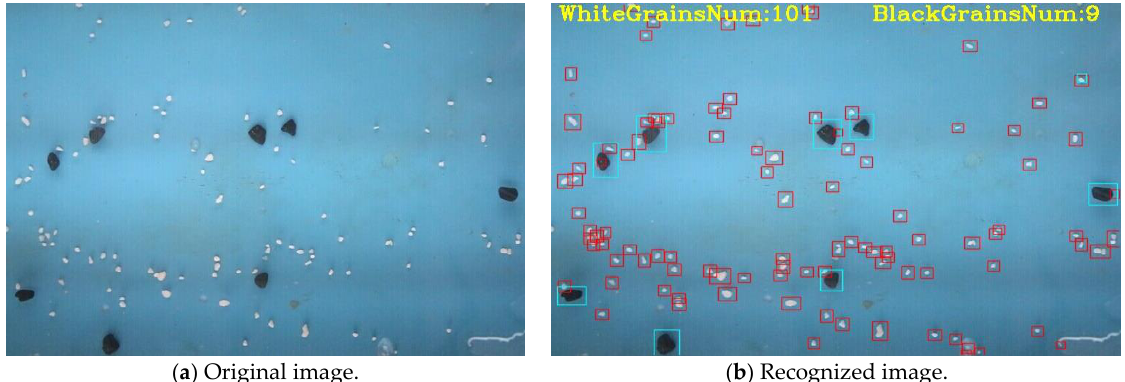
Figure 8. Results of the image-recognition program. The figure shows the recognition result of the program, where ( a ) is the original image captured by the high-speed camera, and ( b ) is the recog- nized image processed by the image-recognition program. The number and the size of the sediments in the sample window of the camera can be obtained. The instant composition of the bed load was acquired by means of image-recognition technology.